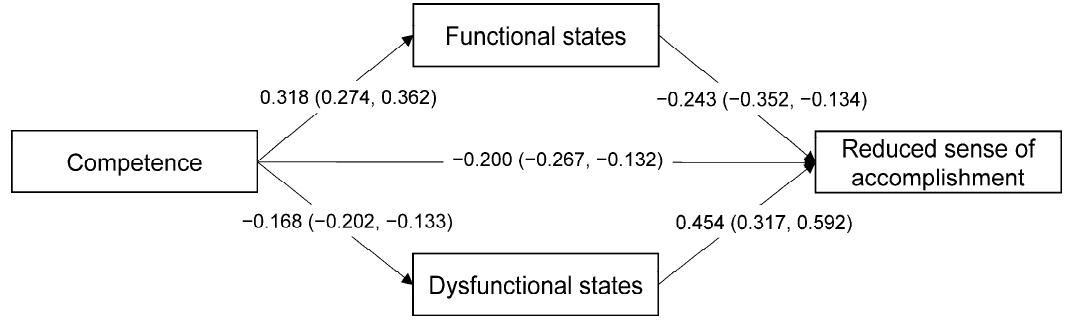
Figure 3. Parallel mediator model on the data of the whole sample. All non-standardized estimates (with 95% confidence intervals) are significant ( p < 0.001).